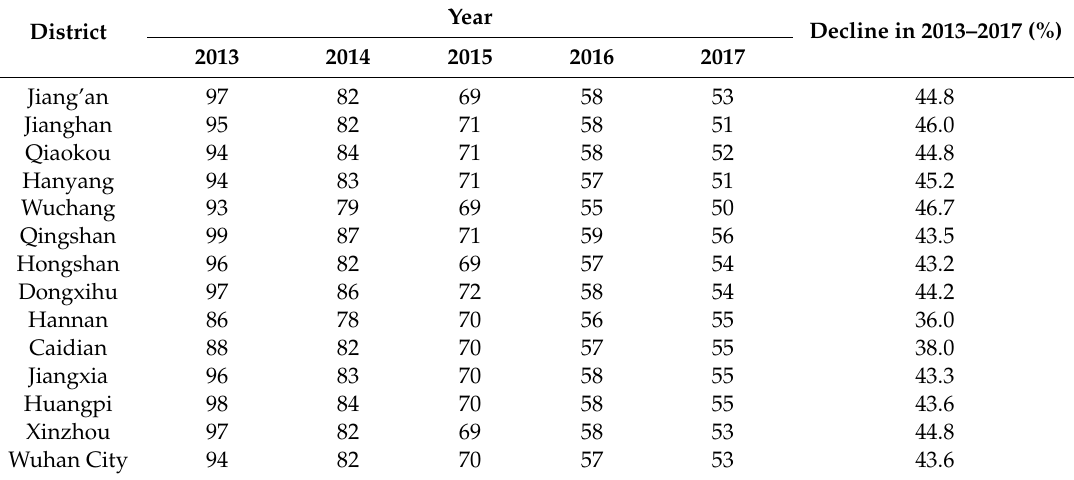
Table 1. Annual average concentrations of PM 2.5 in Wuhan from 2013 to 2017 ( µ g / m 3 ).